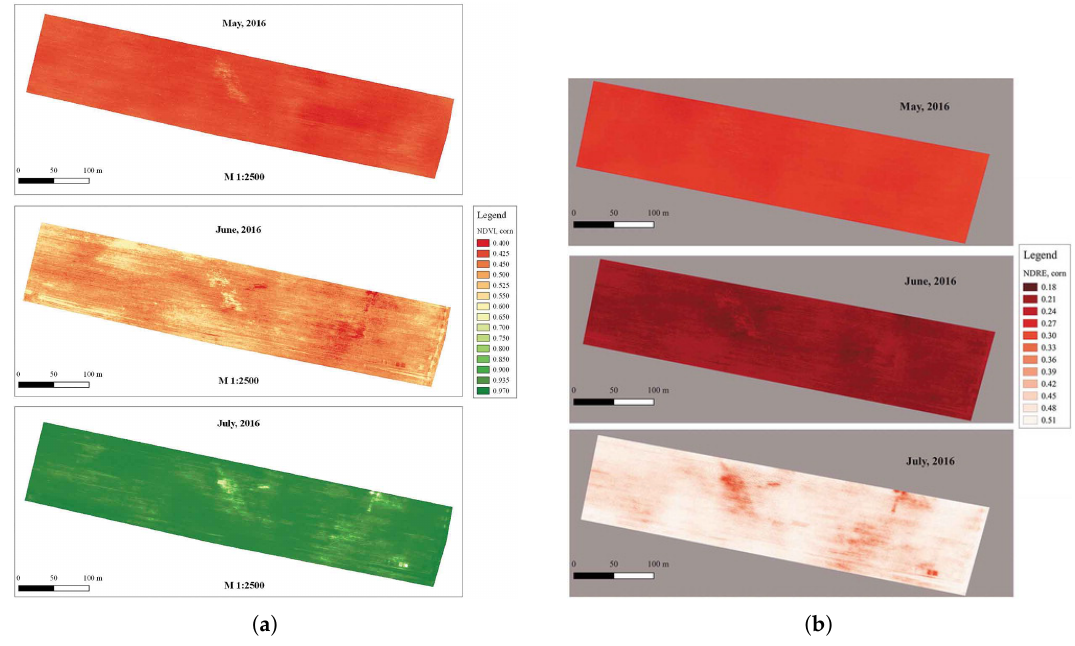
Figure 4. Vegetation indices maps of crops in different growth stages [29]: ( a ) NDVI maps; and ( b ) NDRE